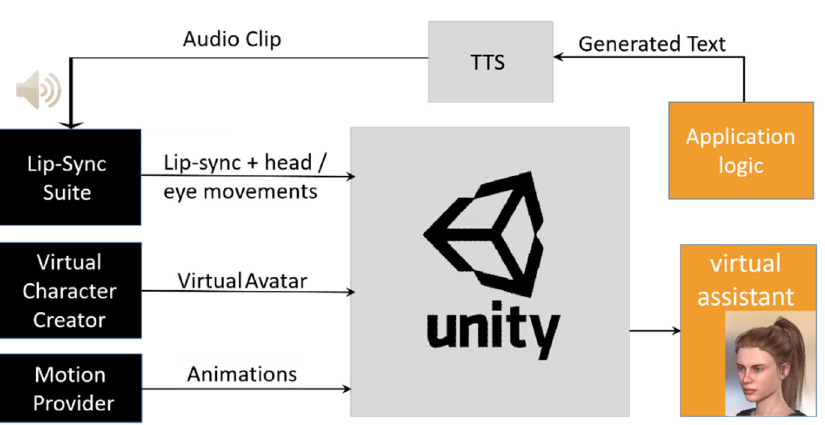
Figure 3. The VA is composed of a Unity scene that incorporates different technologies that work together to provide a complete VA